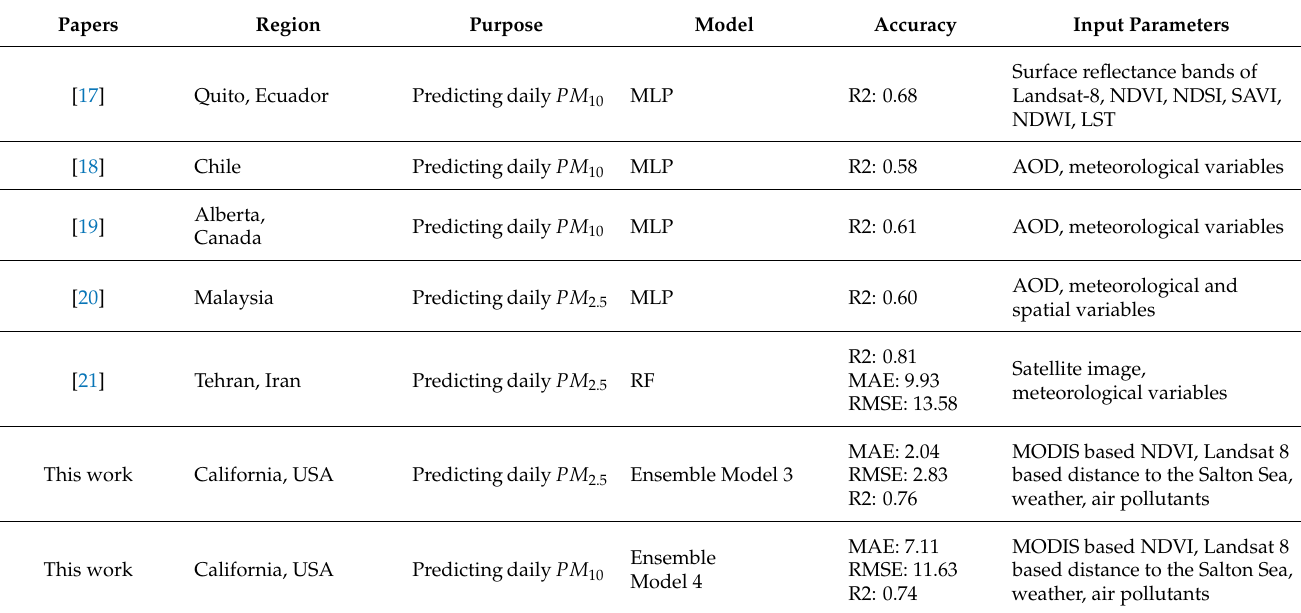
Table 10. Comparison between the models for forecasting particulate matter based on satellite data (created by